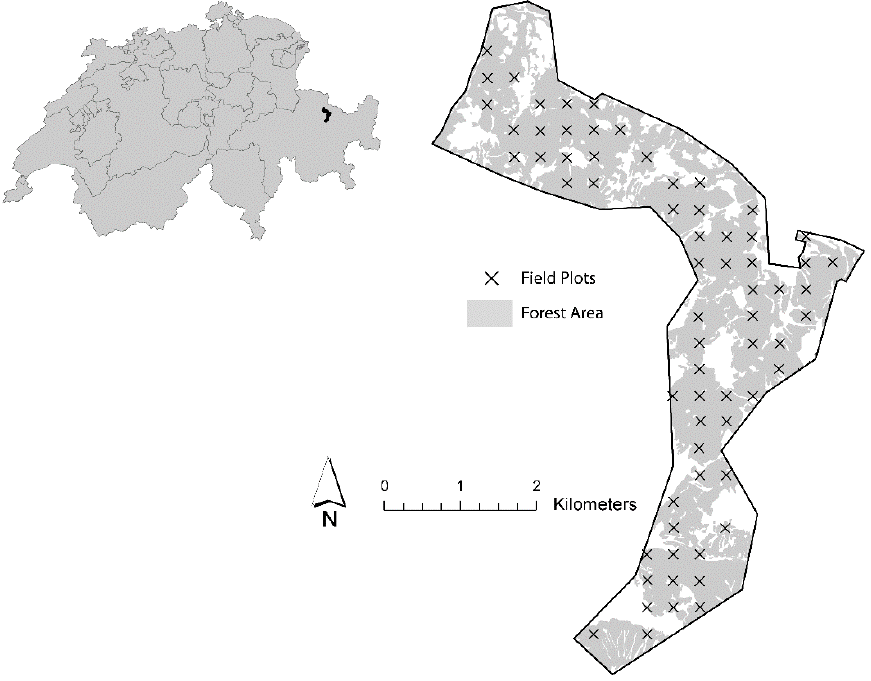
Figure 1. Study site, including the distribution of the 67 field plots (regional forest inventory) that are part of the forest area derived from the TLM3D (Topographic Landscape Model) data (with approval of swisstopo